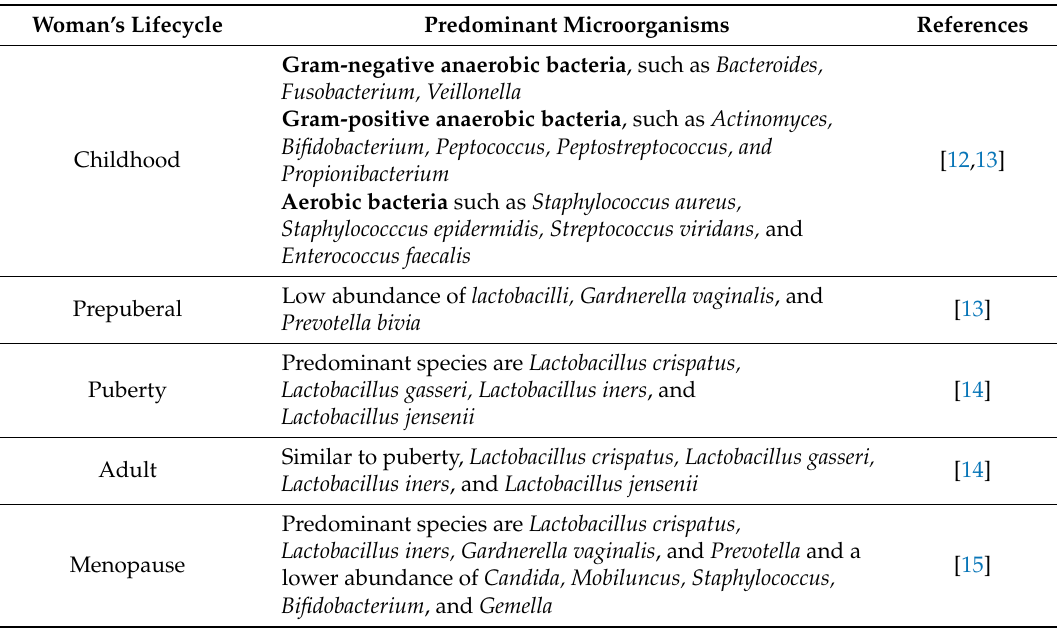
Table 1. Predominant microorganisms throughout the female